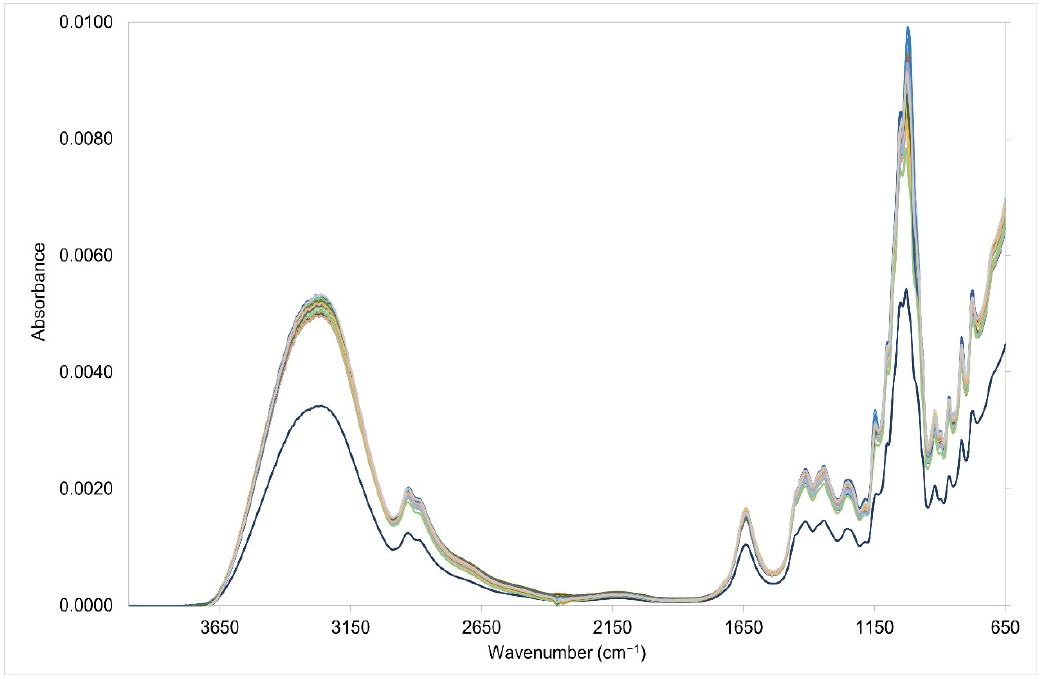
Figure 1. Vector normalized Fourier transform infrared spectra of the training set.